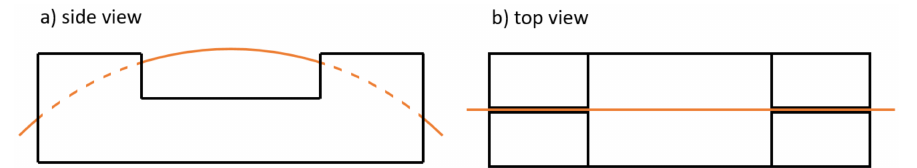
Figure 12. Diagram demonstrating the geometry of an FOS described in [75]. Orange curve denotes an optical fibre.